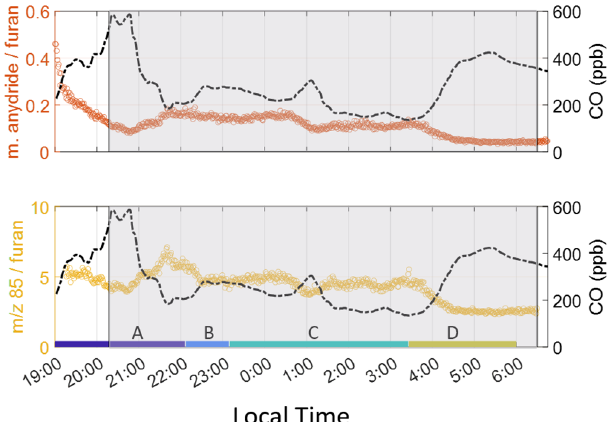
Figure 3. Product-to-reactant ratio for furan oxidation products. Both ratios indicate the period just before sunrise is least oxi- dized. Again, the color labels A–D indicate individual times used to calculate ERs. m/z 85 indicates the sum of furanone and cis-2-